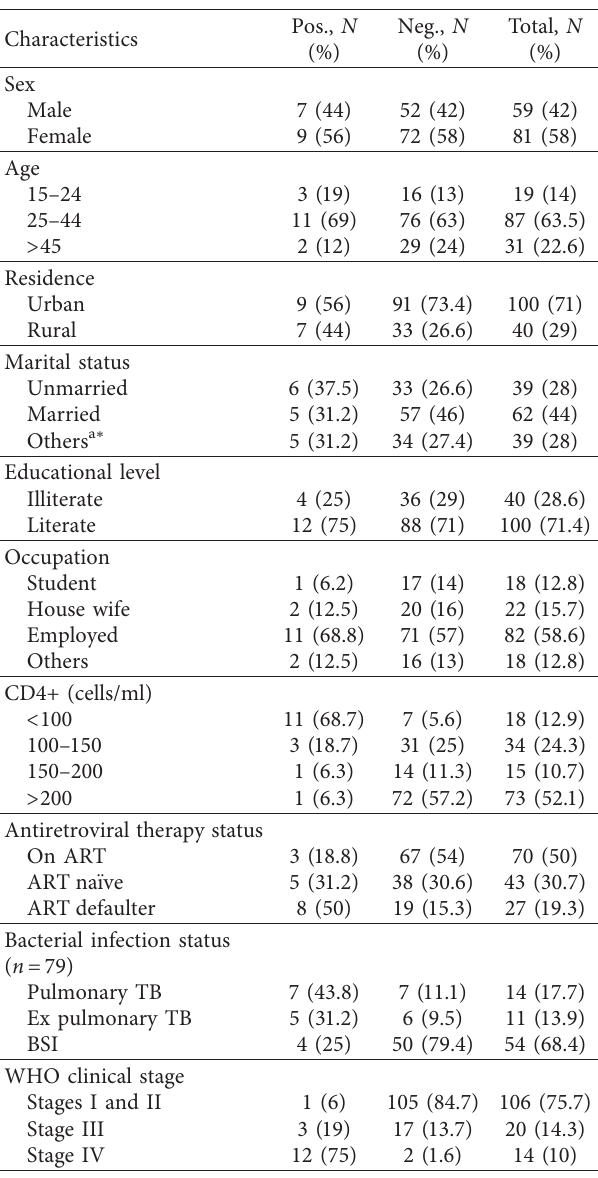
Table 1: Sociodemographic characteristics of HIV/AIDS patients screened for serum cryptococcal antigen in Felege-Hiwot referral hospital, Bahir Dar,